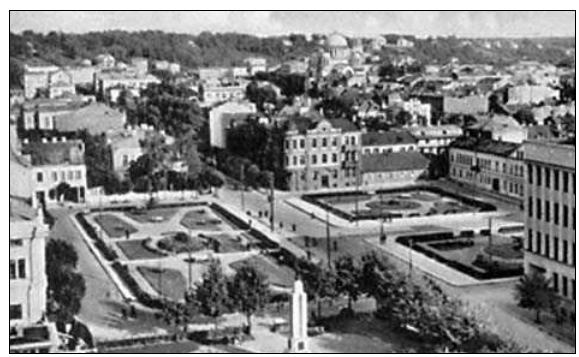
Fig. 1. kaunas Union Square in